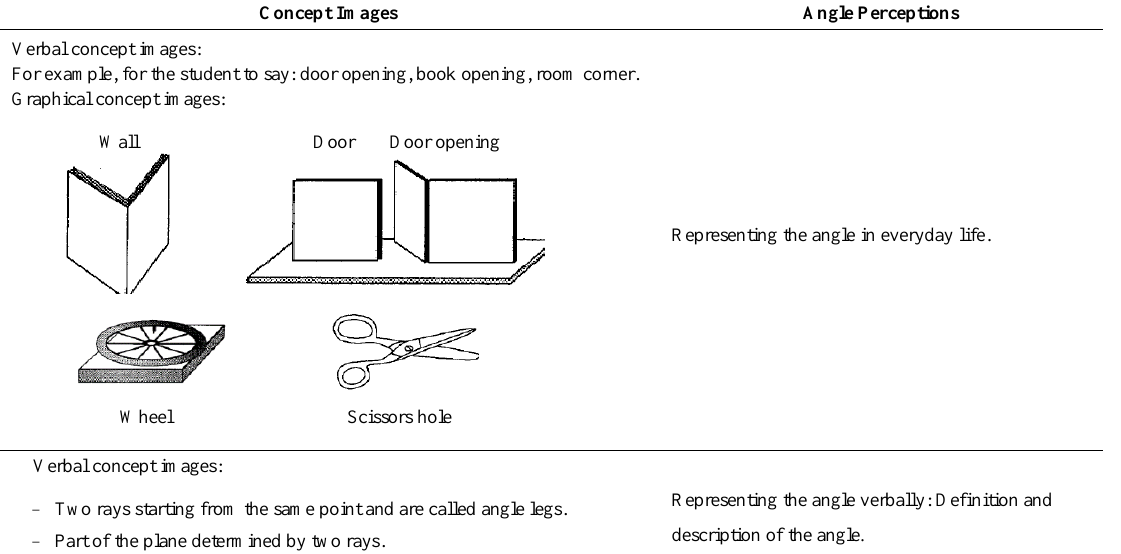
Angle Perceptions Concept Images